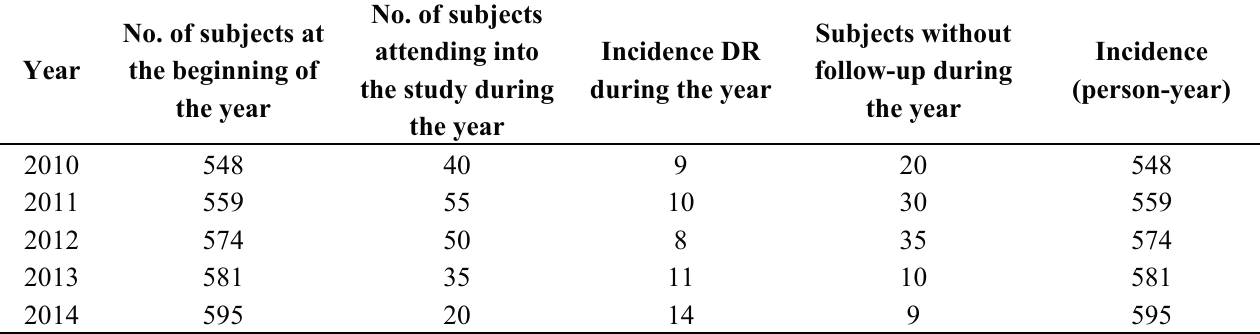
Table 1. Number of survival person-year using life table analysis for DR.